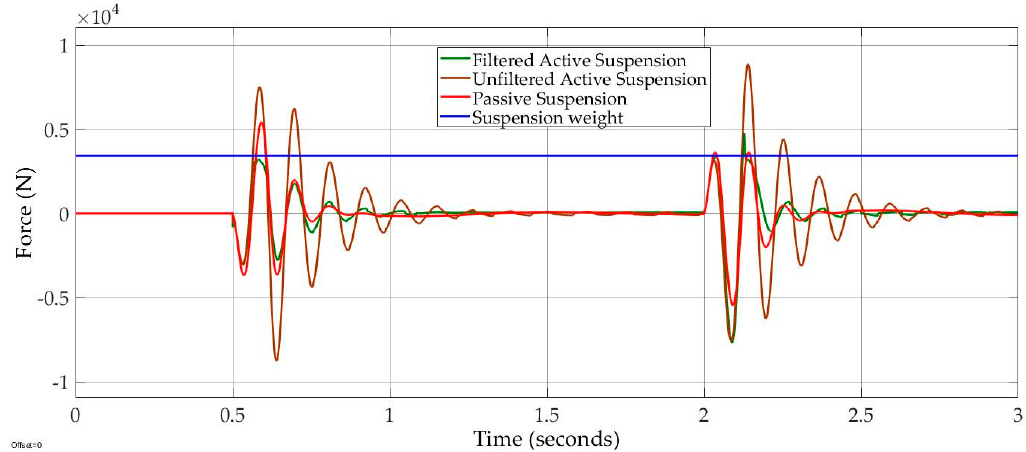
Figure 10. Dynamic tire forces vs. suspension weight of Case 2.